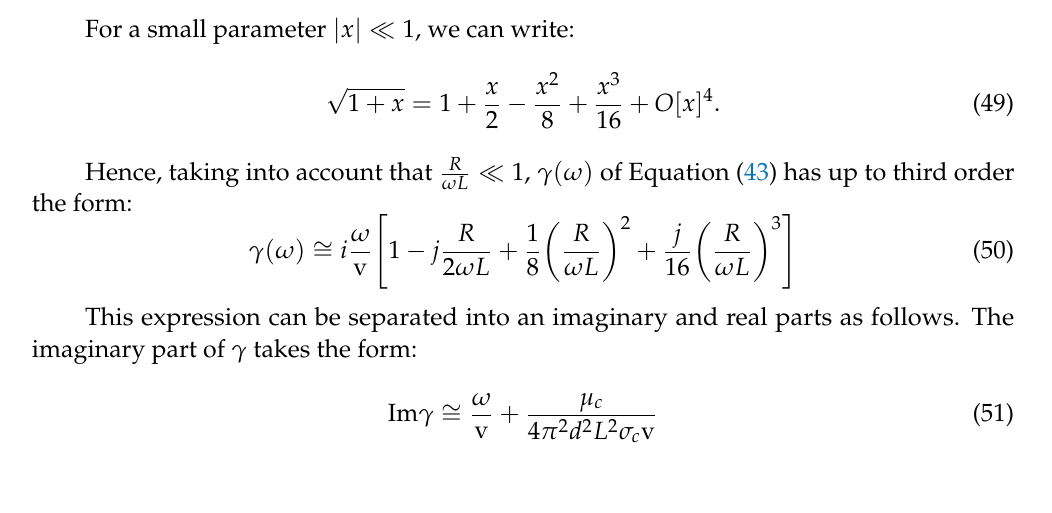
Figure 6. The ratio of resistance to inductance impedance as a function of frequency according to Equation